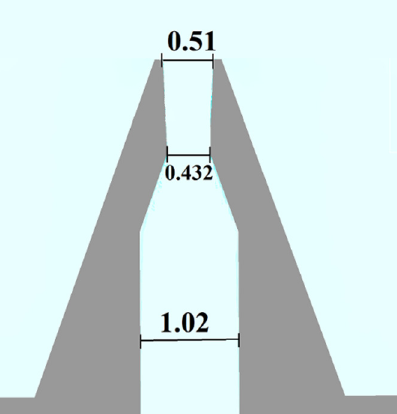
Figure 1. Nozzle geometry from minor axis plane of view, dimensions in inches.